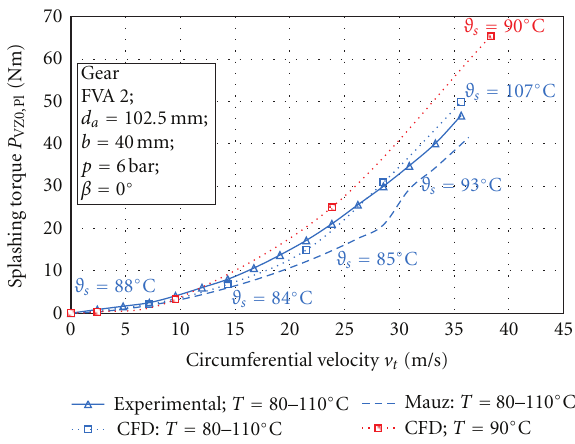
Figure 9: Results in terms of resistant torque versus circumferential velocity—e ff ect of the temperature.